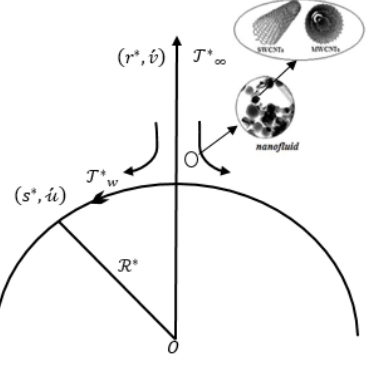
Figure 1. Physical illustration of the flow problem.